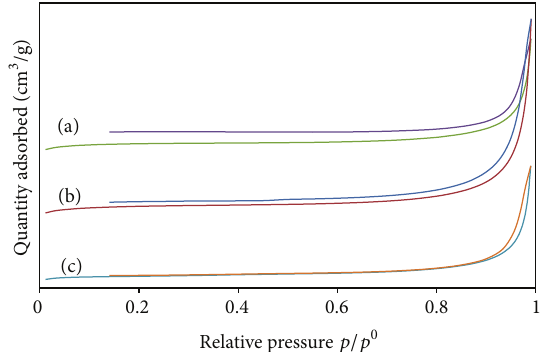
Figure 2: XRD patterns of (a) WO 3 NPs and WO 3 -Ppy. PNCs with particle loadings of (b) 5, (c) 10, (d) 15, (e) 20wt%, and (f) pure Ppy, respectively.